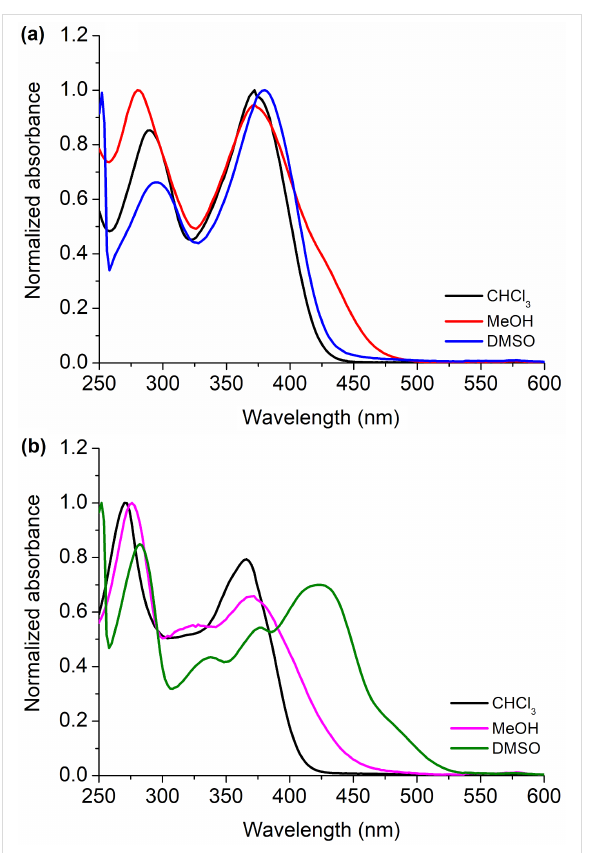
Figure 3: Normalized absorption spectra in the UV–vis region of com- pounds (a) 3ea and (b) 3be in CHCl 3 , MeOH or DMSO solution, re- spectively ([ ] = 1.50 × 10 − 5